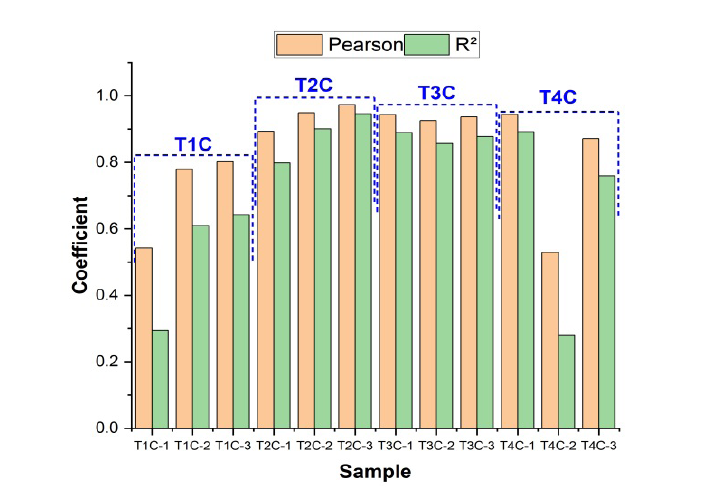
Figure 11. Pearson (r) and determination (R 2 ) coefficients per sample.